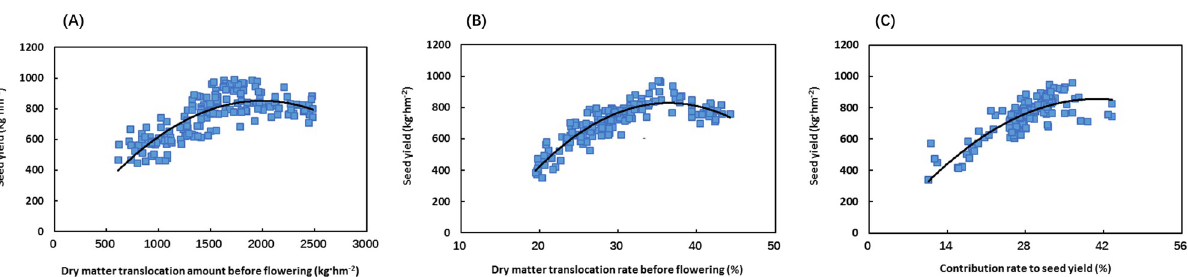
Fig 5. Relationship between dry matter translocation and seed yield of Chinese milk vetch. (A) Relationship between seed yield and dry matter translocation amount of vegetative organs before flowering ( Y = -0 . 0002X 2 + 0 . 9483X – 93 . 309 , R 2 = 0 . 6382 , P < 0 . 001 , n = 180 ). (B) Relationship between seed yield and dry matter translocation rate of vegetative organs before flowering ( Y = -1 . 4937X 2 + 108 . 78X – 1152 . 2 , R 2 = 0 . 7143 , P < 0 . 001 , n = 180 ). (C) Relationship between seed yield and dry matter contribution rate of vegetative organs to seed yield before flowering ( Y = -0 . 5781X 2 + 47 . 142X – 105 . 53 , R 2 = 0 . 6833 , P < 0 . 001 , n = 180 ). All the experiments are shown.